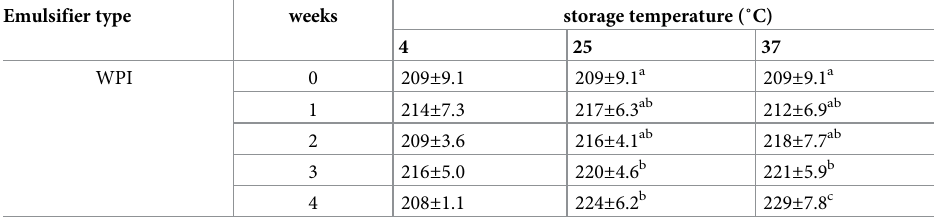
Table 4. Storage stability of lutein-loaded emulsions.